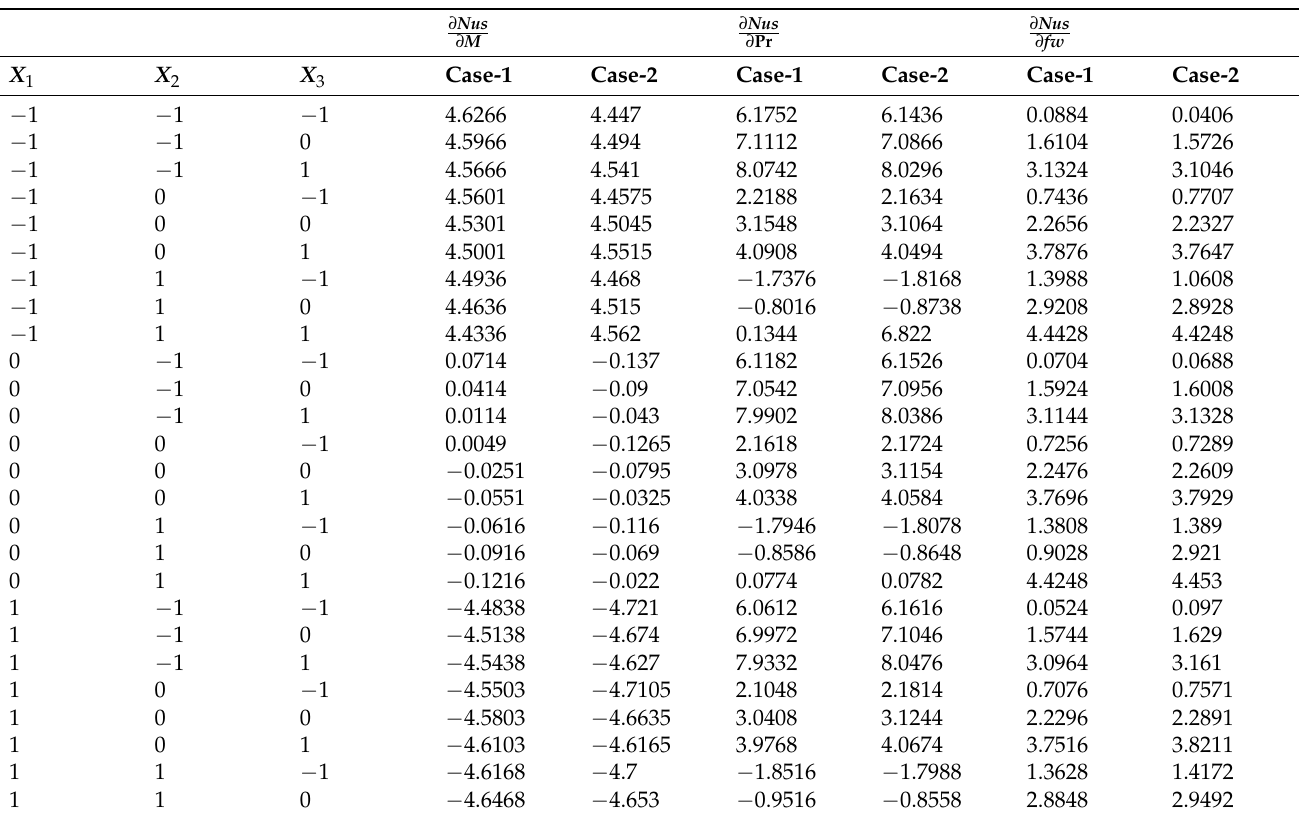
Table 6. Sensitivity values at all levels of the key